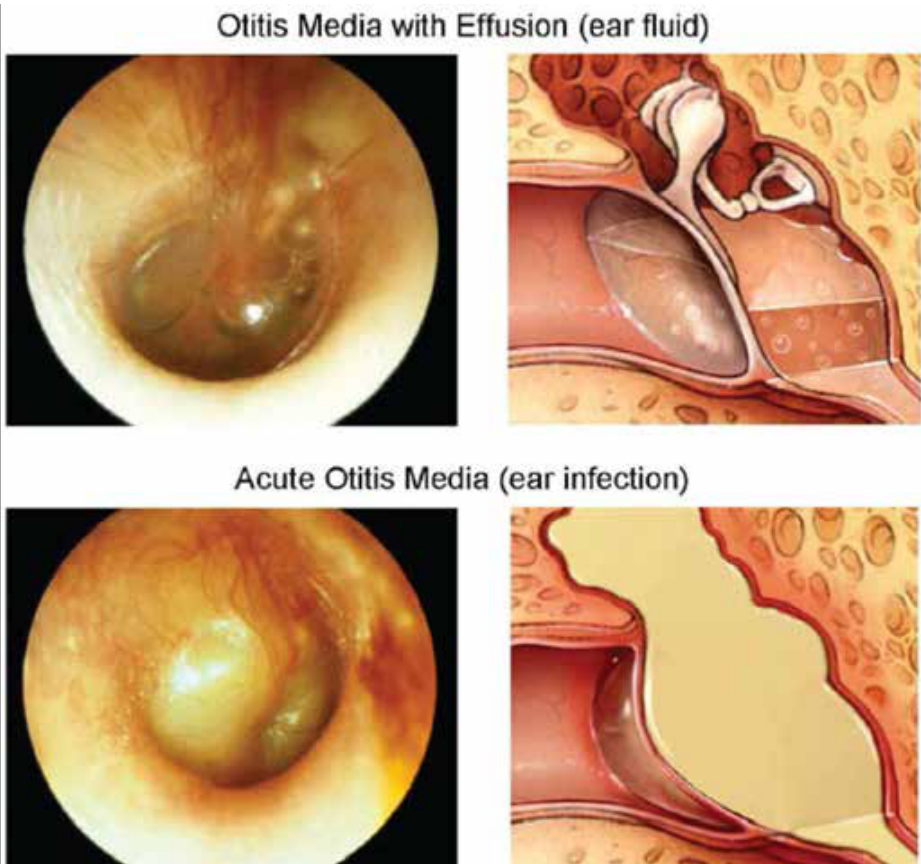
Figure 1: Comparison of otitis media with effusion (top) and acute otitis media (bottom). The left images show the appearance of the eardrum on otoscopy, and the right images depict the middle ear space. For otitis media with effusion, the middle ear space is filled with mucus or liquid (top right). For acute otitis media, the middle ear space is filled with pus, and the pressure causes the eardrum to bulge outward (bottom right). (With permission from Rosenfeld 2016 5